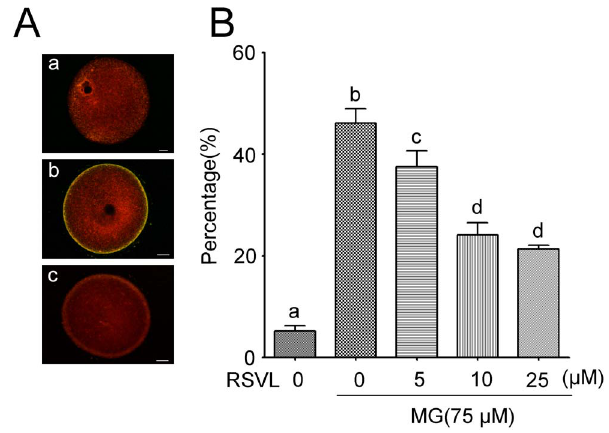
Figure 6. MG and resveratrol-induced oocyte membrane lipid peroxidation in vitro. ( A ) ( a ), ( b ) and ( c ) Representative images of BODIPY-labeled control group, MG-treated group and resveratrol-MG- treated group oocytes. Scale bar =20 m m. ( B ) Levels of lipid peroxidation as observed by the of green fluorescence on cortical areas. The bar chart shows the percentage of oocytes with high level of lipid peroxidation from control group, 75 m M MG-treated group and different concentrations of RSVL-MG-treated group (5, 10 and 25 m M). Data are mean 6 SEM of three independent experiments. Different letters denote statistically significant differences ( P , 0.05). PLOS ONE |